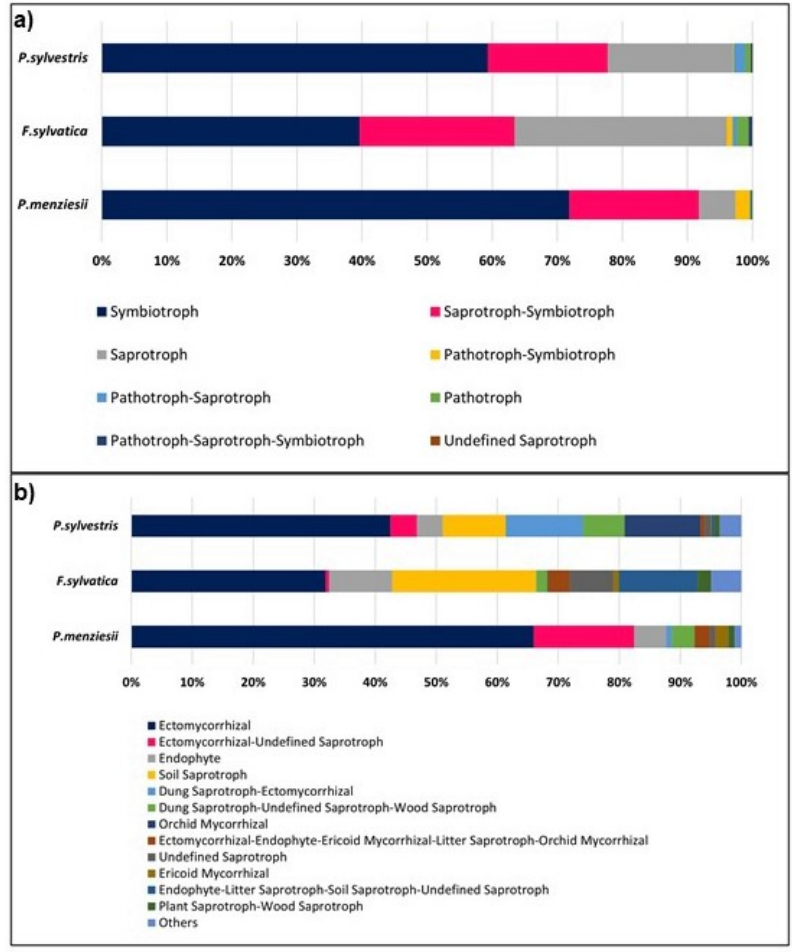
Figure 4. Fungal trophic mode ( a ) and functional group ( b ) in Pseudotsuga menziesii , Fagus sylvatica , and Pinus sylvestris roots on experimental plots, inferred through FUNGuild.